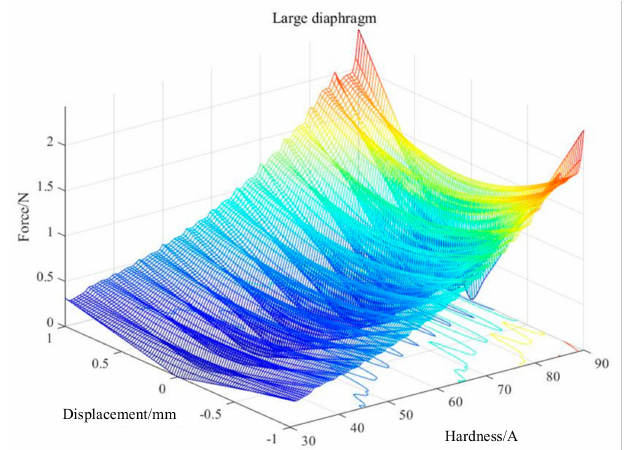
Figure 12. Movement resistance of large RD.